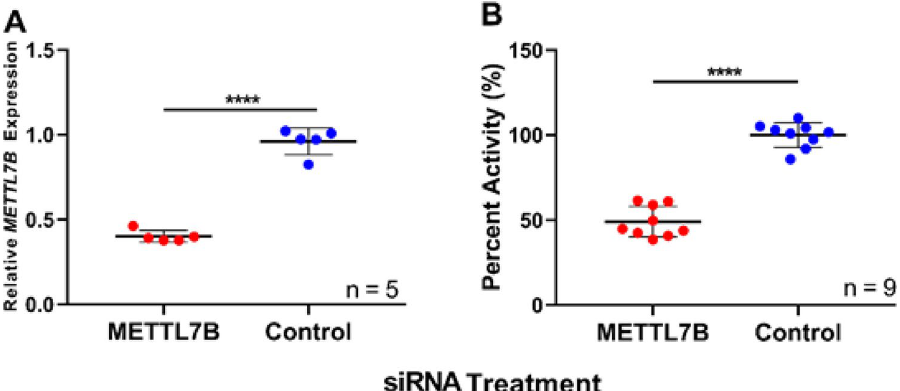
Figure 1. Knockdown of METTL7B gene expression in HepG2 cells: ( A ) RT-PCR data measuring METTL7B gene expression following treatment with METTL7B siRNA for 72 h compared to scramble treated control. ( B ) HepG2 S- methyl captopril formation following 24 h incubation in cells treated with METTL7B siRNA (72 h) compared to scramble control. All data is presented as the mean ± s.d. Individual data points are plotted from two ( A ) or three ( B ) separate experiments. Significance was determined using unpaired two-tailed t test. **** P <